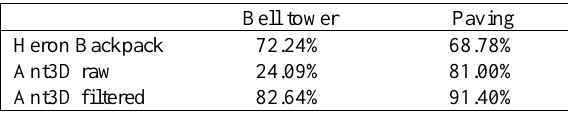
Table 6. Percentages of points with a C2M distance less than 3